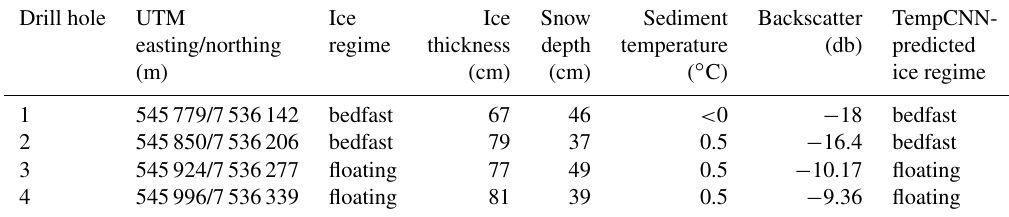
Table 4. Field data collected in April 2021 on a small lake located beside the drained basin of Zelma Lake. For each of the four locations, UTM coordinates, ice regime, ice thickness, snow depth, and sediment temperature are matched with the TempCNN